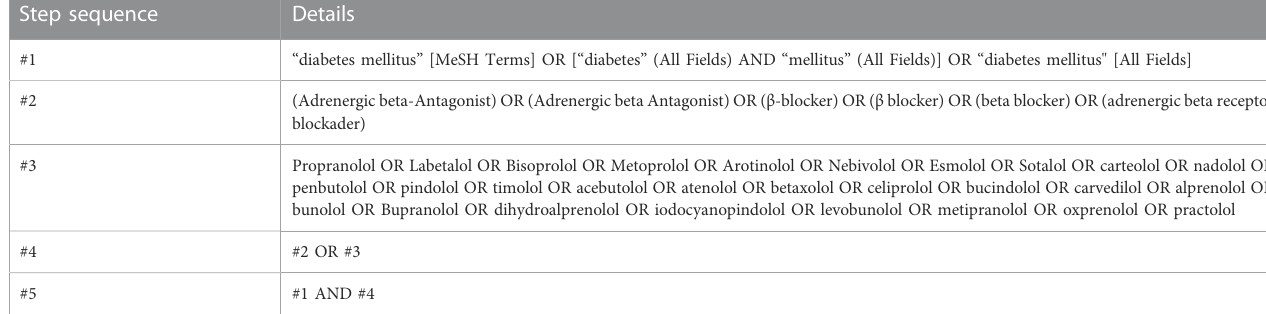
TABLE 1 Searching strategy in